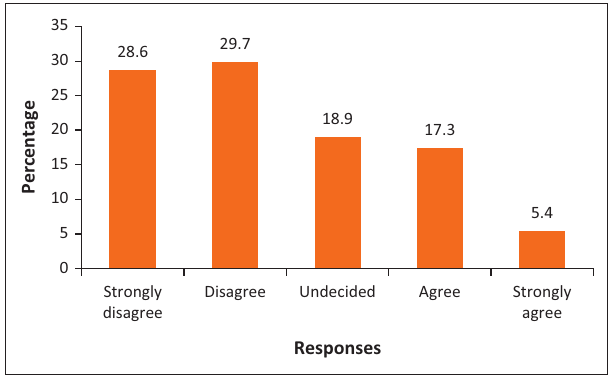
FIGURE 1: Public involvement in municipal